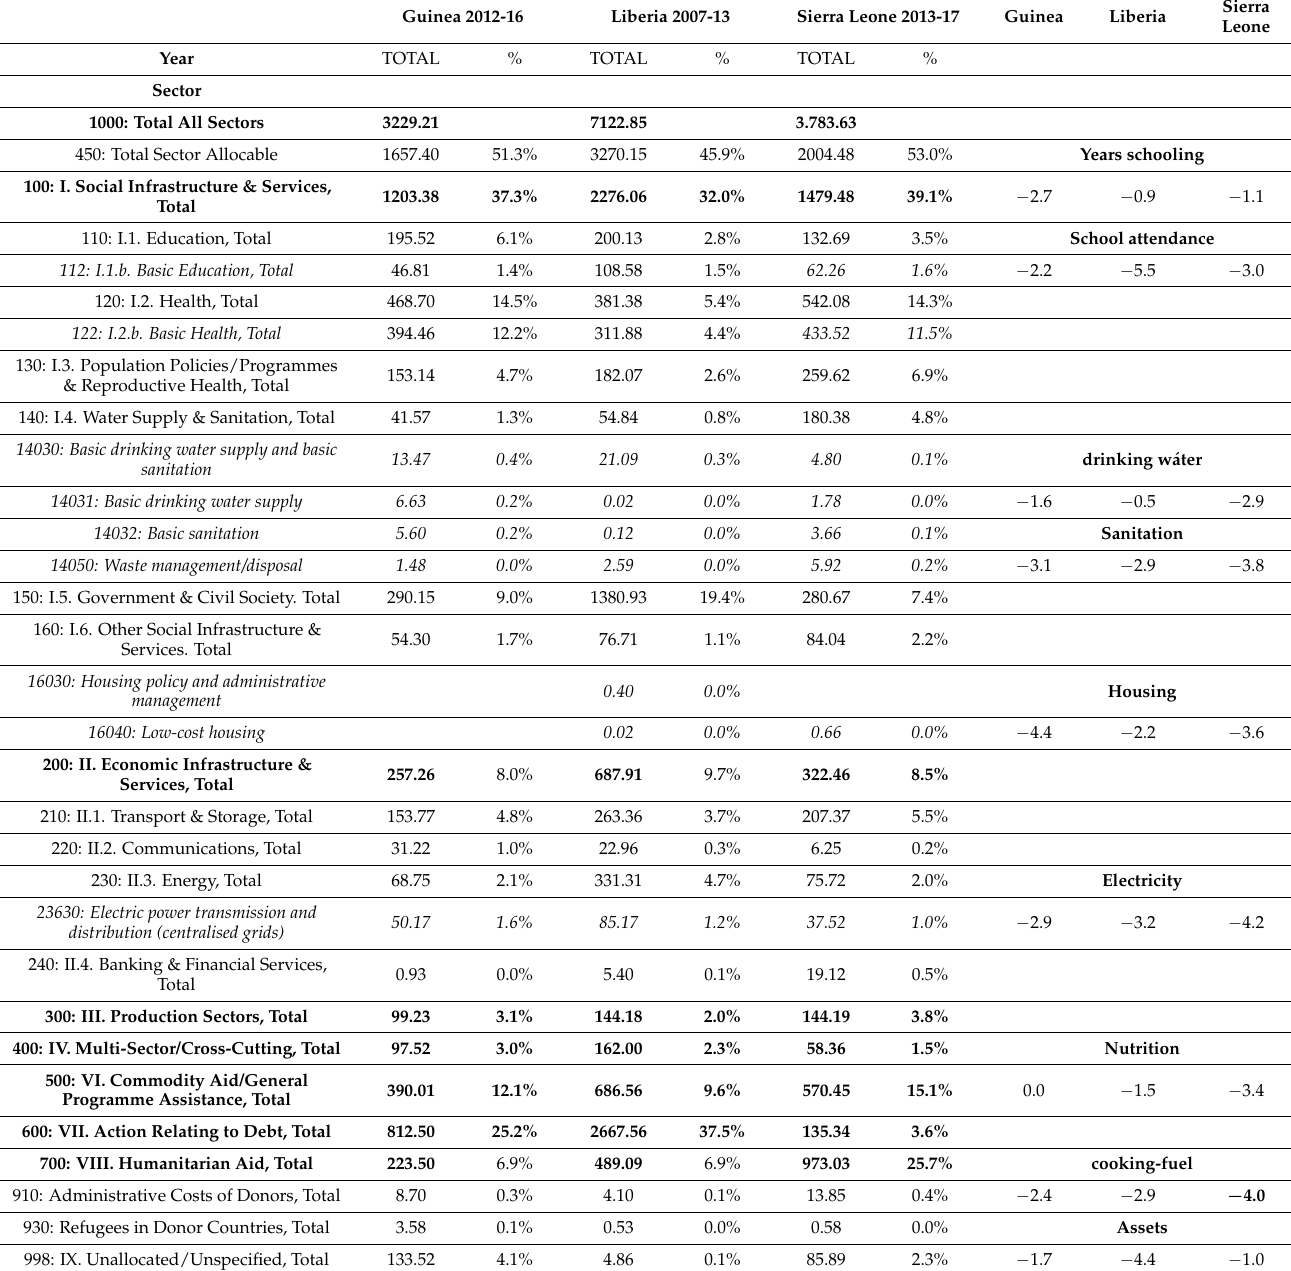
Table 6. ODA by sector for Guinea (2012-16), Liberia (2007-13) and Sierra Leone (2013-17). Guinea 2012-16 Liberia 2007-13 Sierra Leone 2013-17 Guinea Liberia Sierra